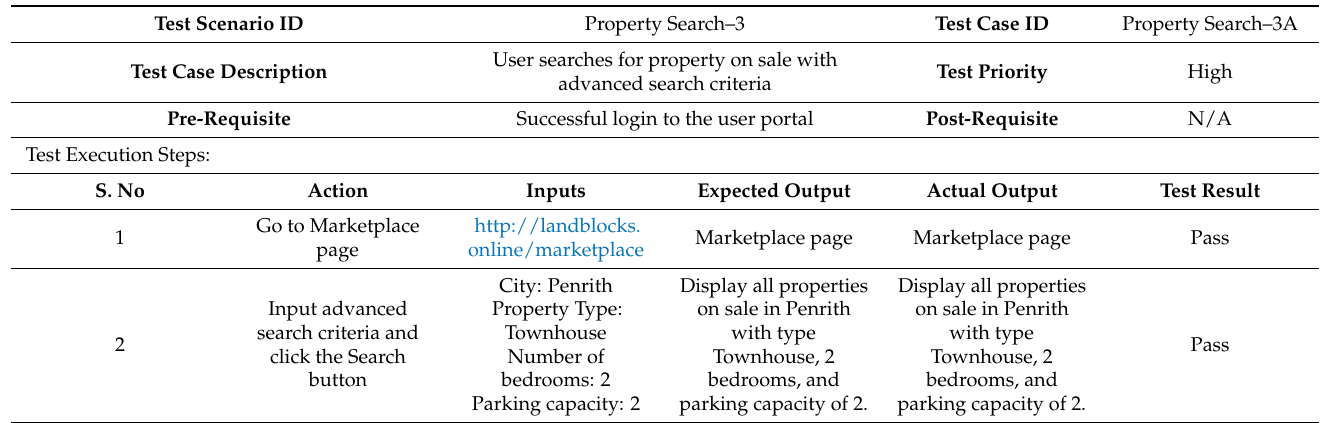
Table 4. Example test case